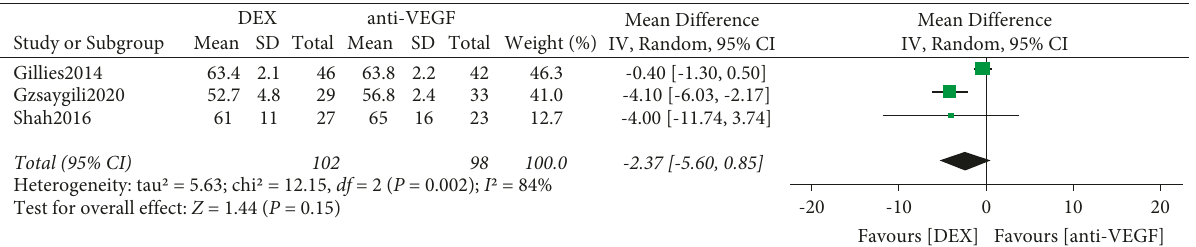
Figure 2: Forest plot of BCVA for